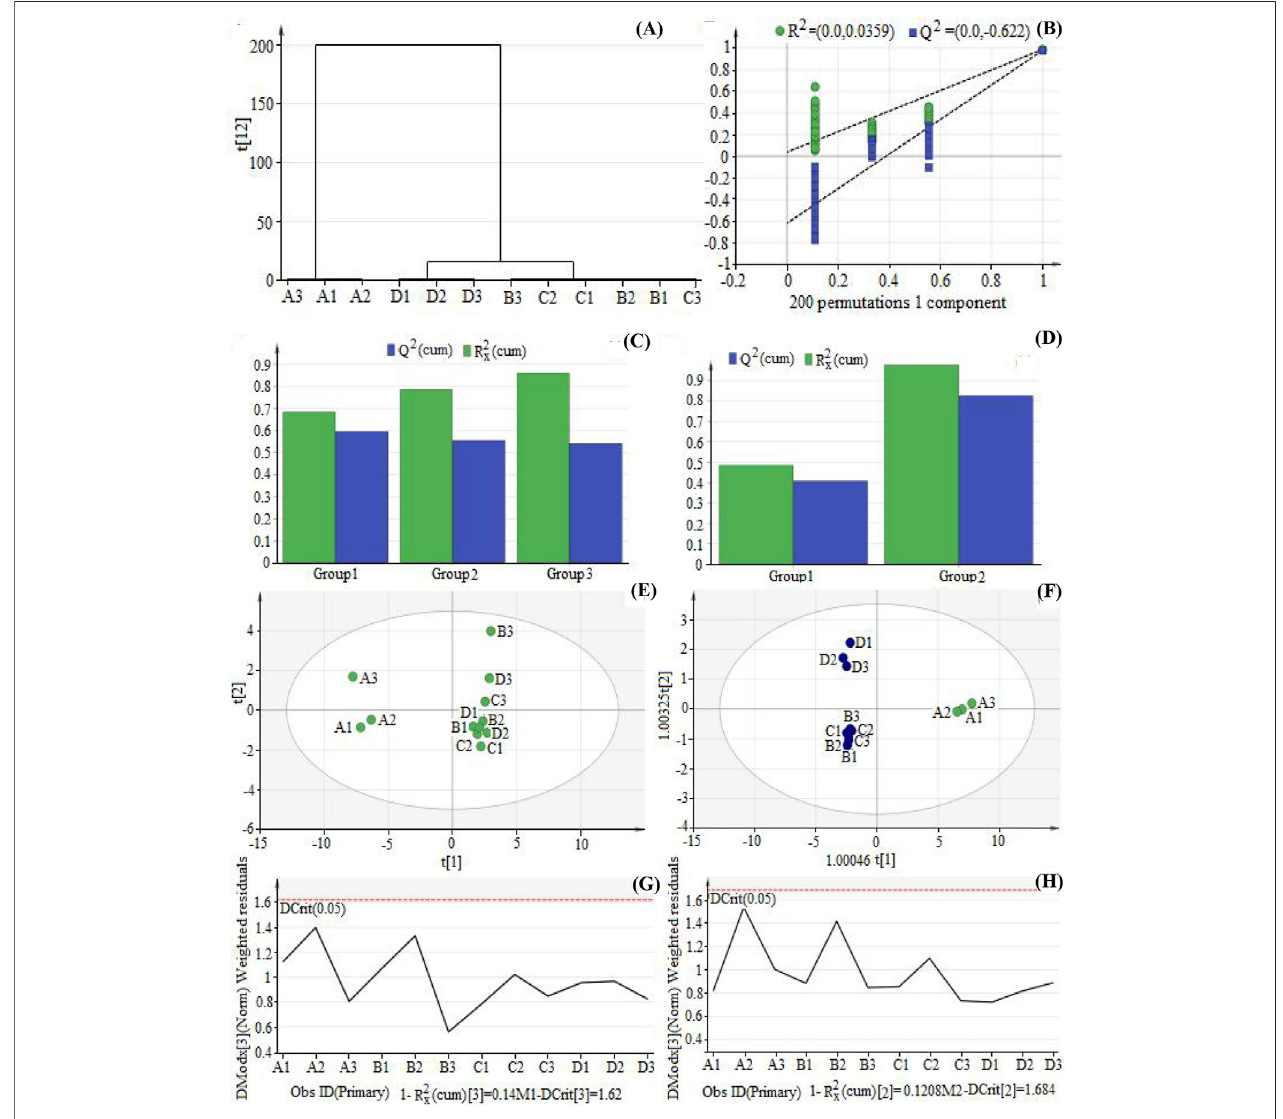
FIGURE 2 | Hierarchical clustering analysis (HCA) analysis, Principal component analysis (PCA) analysis, and Orthogonal partial least squares discrimination analysis (OPLS-DA) analysis. (A) The diagram of HCA; (B) The result of permutation text of OPLS-DA; (C) The fi tting result of PCA; (D) The fi tting result of OPLS-DA; (E) Score plot of PCA; (F) Score plot of OPLS-DA; (G) Distance to model (DModx) plot of PCA; (H) DModX Plot of OPLS-DA. A1, A2, A3 represent bio-enzymatic method; B1, B2, B3 represent re fl ux method; C1, C2, C3 represent ultrasonic method; D1, D2, D3 represent ultrasound-assisted enzymatic method.